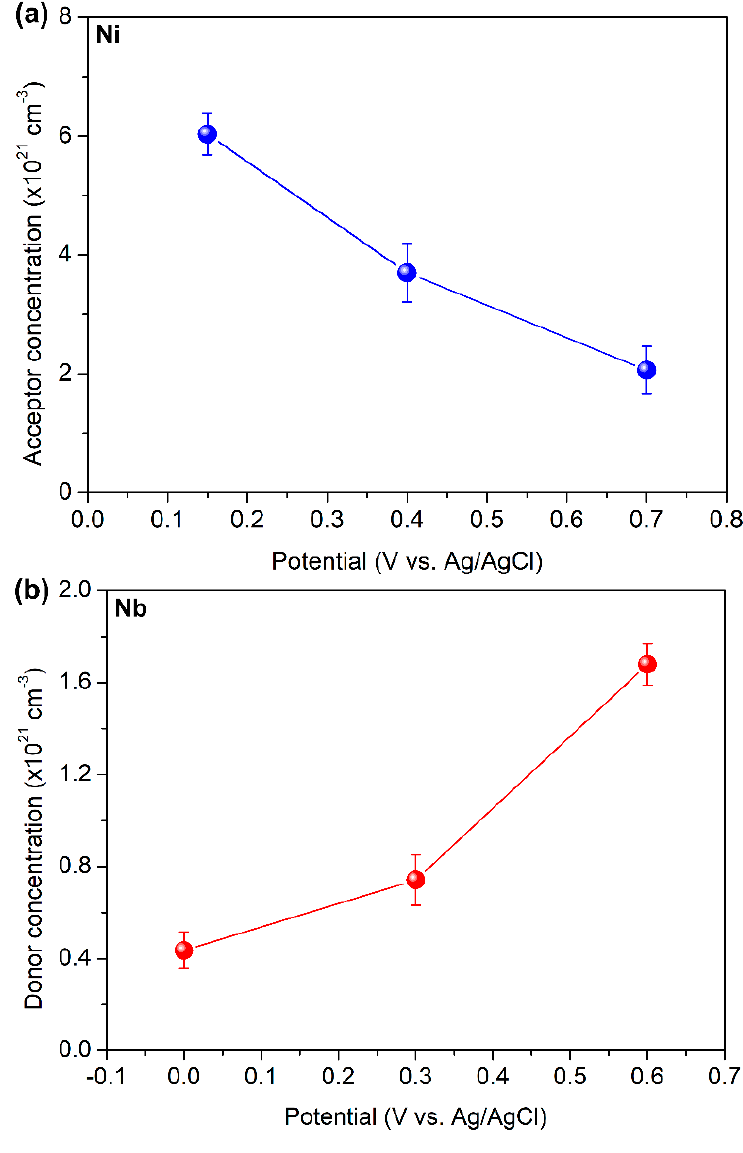
Figure 14. Defect concentration in the passive films formed at different potentials: ( a ) Ni and ( b )